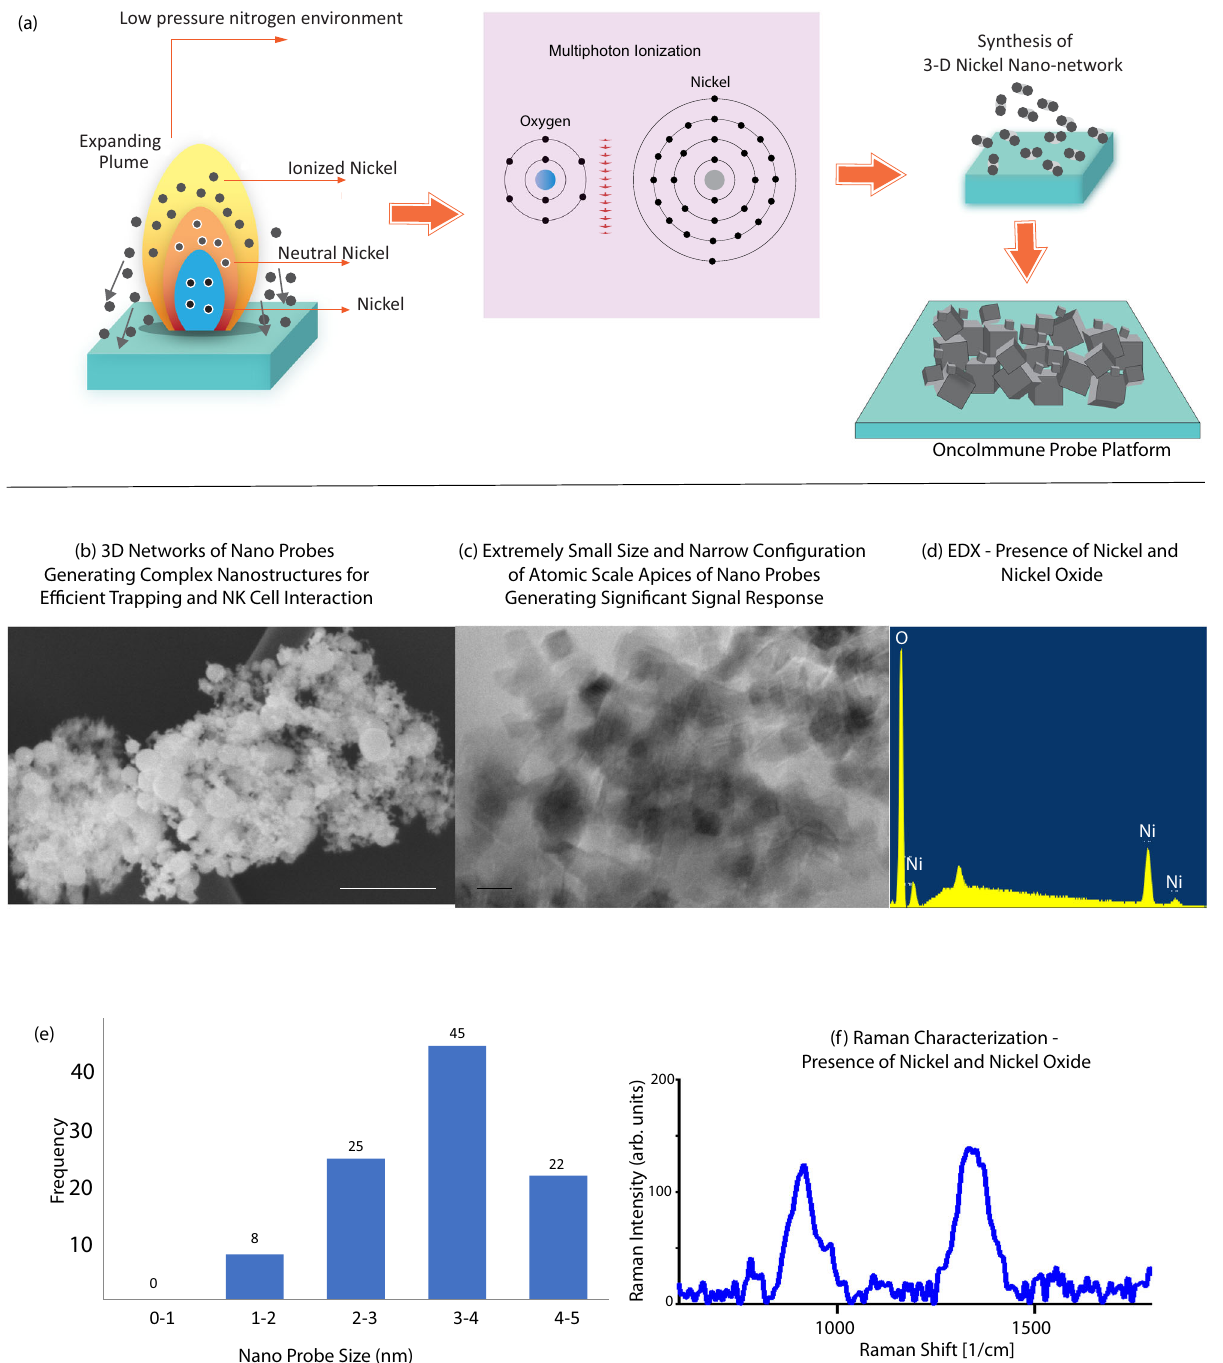
Fig. 2 | Synthesis and characterization of OncoImmune probe platform for in- silico detection of cancer. a Schematic representation of multiphoton ionization resulting in the formation of intricate 3Dnickel nano network of the Oncoimmune probe platform. b High-resolution scanning electron microscopy (HRSEM) image of the OncoImmune probe platform demonstrating 3D networks of the probes generating maze-like sensing platform. Scale bar = 200nm. c High-resolution transmission electron microscopy (HRTEM) demonstrating the small size of the